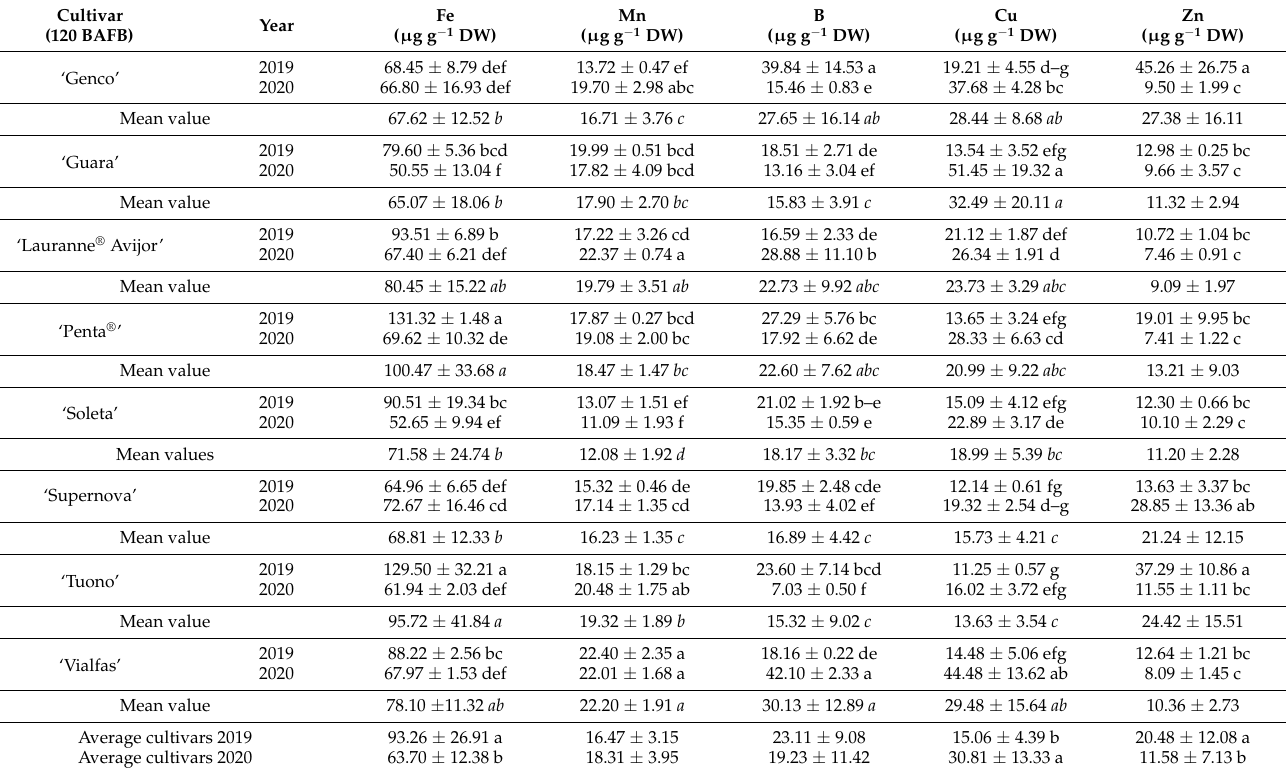
Table 6. Micronutrients content ( µ g g − 1 DW) in almond leaves collected at 120 DAFB over the years 2019–2020. (Fe = iron, Mn = manganese, B = boron, Cu = copper, Zn = zinc). Data are presented as mean ± standard deviation. Different lowercase letters on the columns indicate significant differences between means (Fisher’s test p < 0.05). Lowercase letters in italics describe the differences expressed as two-year mean values of the